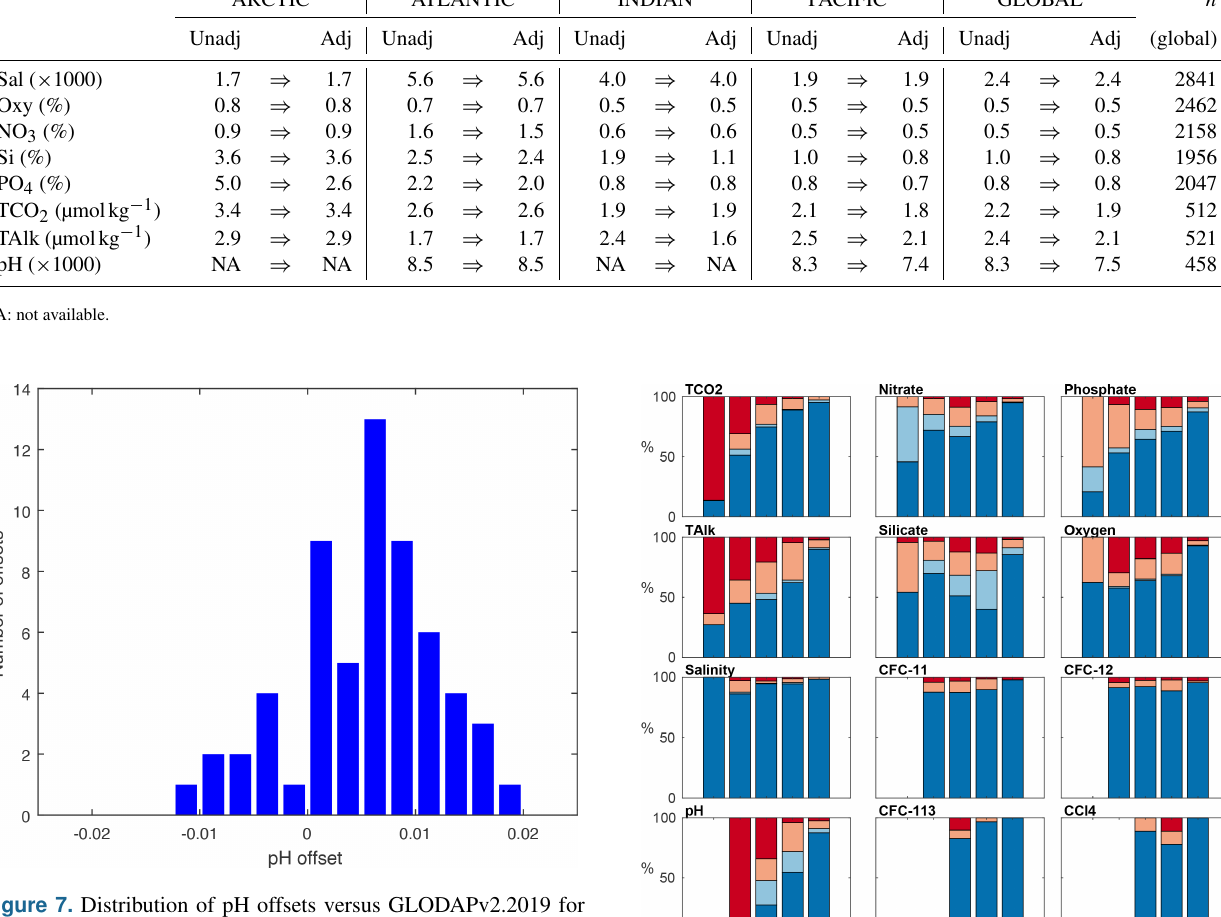
Figure 7. Distribution of pH offsets versus GLODAPv2.2019 for the cruises from the Japan Meteorological Agency added in GLO- DAPv2.2020.